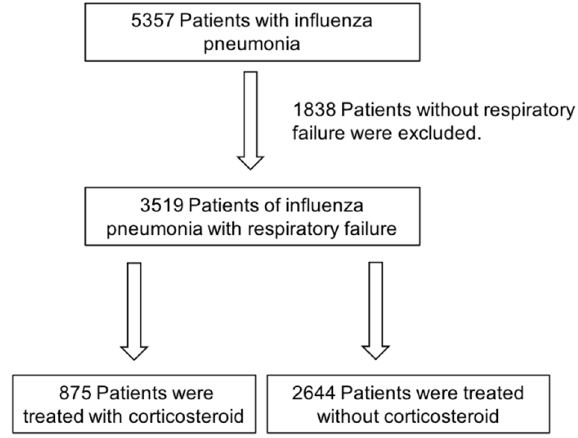
Figure 1. Flow chart of patient selection.